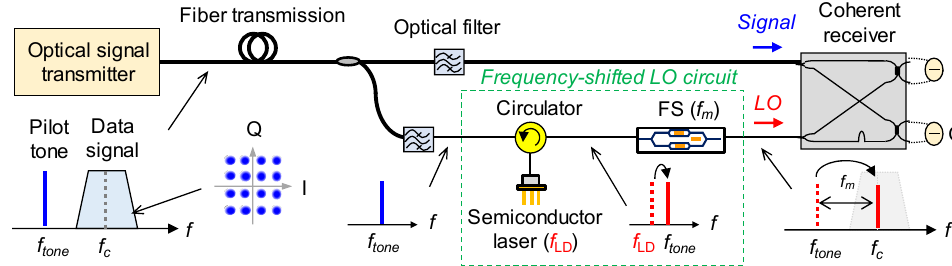
Figure 1. Schematic of coherent optical communication system based on frequency-shifted LO.